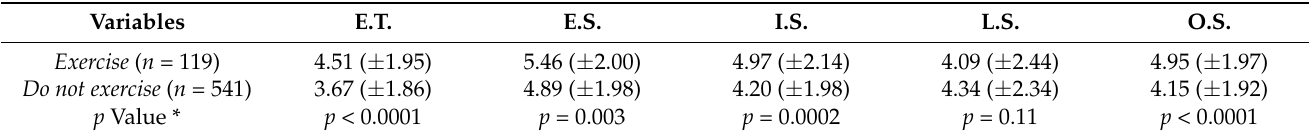
Table 7. Differences in score obtained on the KPS scale and